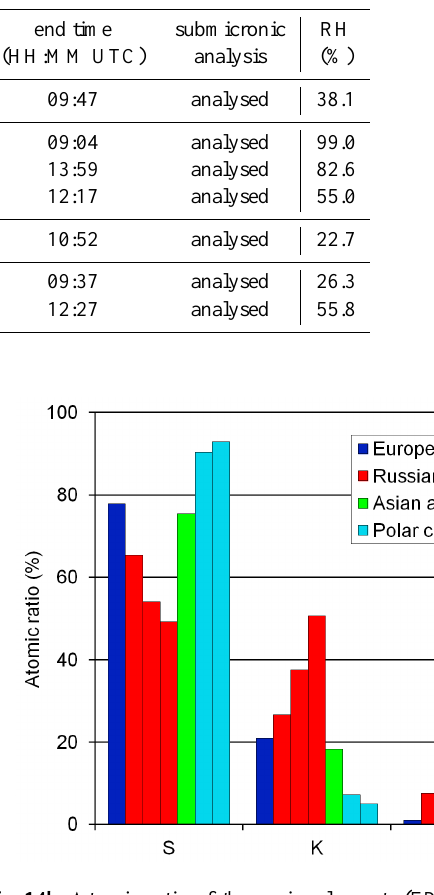
Fig. 14b. Atomic ratio of the major elements (EDX) among indi- vidual submicron aerosol